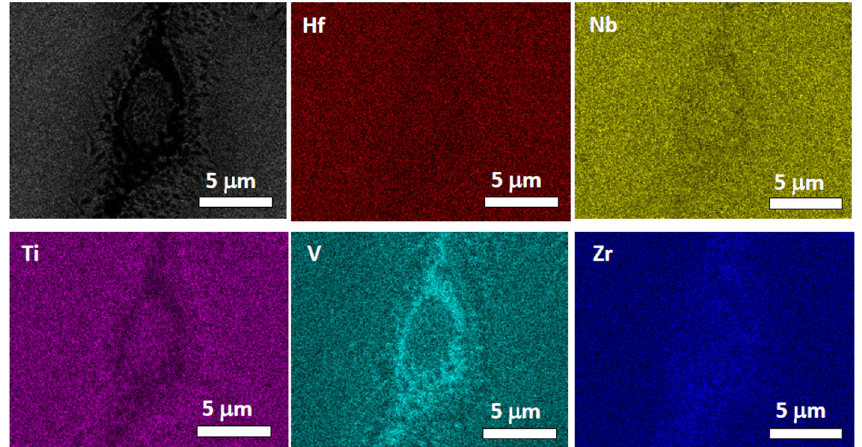
Figure 12. SEM micrograph (back-scattered electrons) of HfNbTiVZr alloy in the as-cast state: ( a ) an overview of the microstructure, ( b ) detail of grain boundary with V-rich particles.